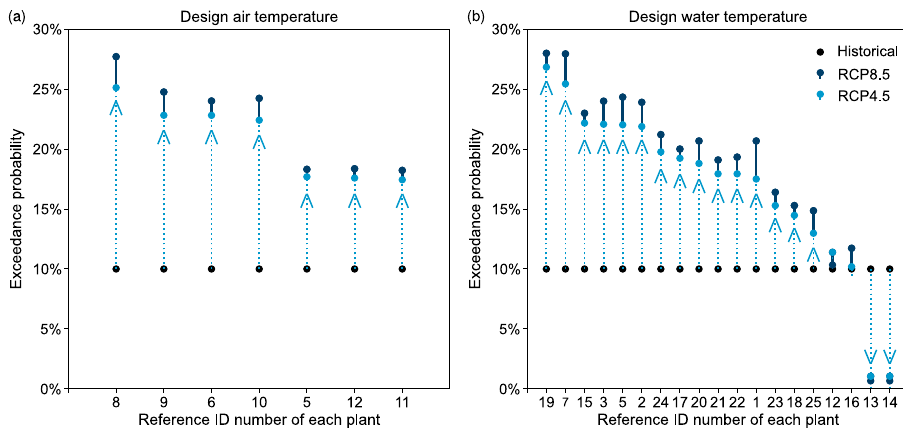
Fig. 5 Exceedance probability of design air and water temperatures in baseline and future periods by power plants. a represents designed air temperatures. b represents designed water temperatures. The direction of the arrow at the end of each vertical line indicates the changing trend for each plant. The vertical lines in both plots are sorted in descending order of the probability under RCP4.5.